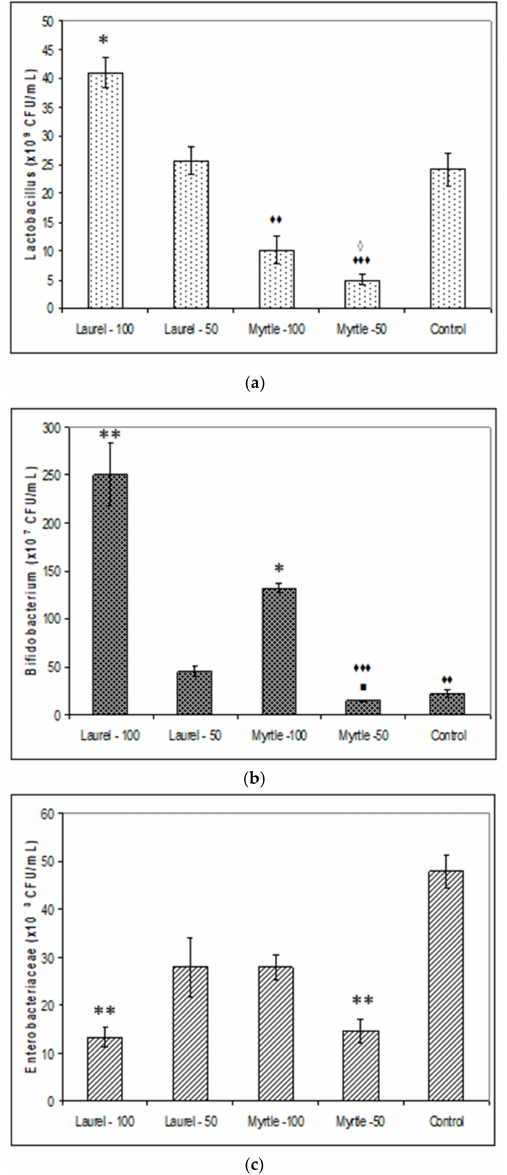
Figure 2. The effect of Laurel and Myrtle extract on the number of colonies of Lactobacillus ( a ), Bifidobacterium ( b ) and Enterobacteriaceae ( c ) formed on selective media. Male rats ( n = 5) were administered Laurel and Myrtle extracts ig at a dose of 50 and 100 mg/kg once a day for 14 days. The control group was treated with ig saline. The results are expressed as the mean value of each experimental group ± SE of the mean of two different observations. * Significantly different in relation (cid:7) (cid:7)(cid:7) p to the control (* p < 0.05; ** p < 0.01). Significantly different in relation to Laurel-100 ( < 0.01; (cid:7)(cid:7)(cid:7) p (cid:4) (cid:4) p ♦ < 0.001). Significantly different in relation to Myrtle-100 ( < 0.05). Significantly different ♦ p in relation to Laurel-50 ( <